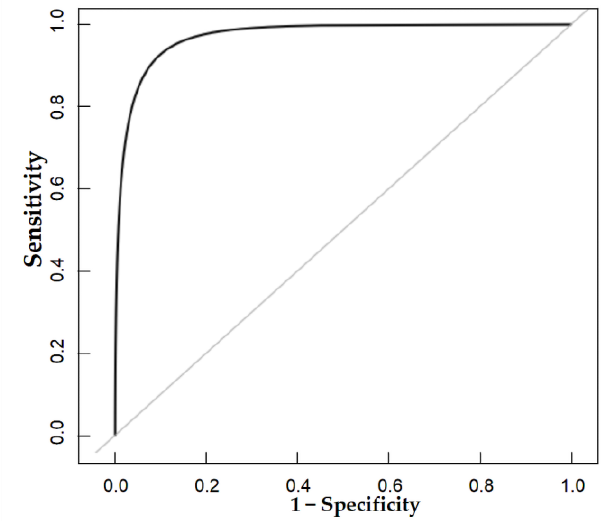
Figure 7. The AUC of the internal validation of our model.